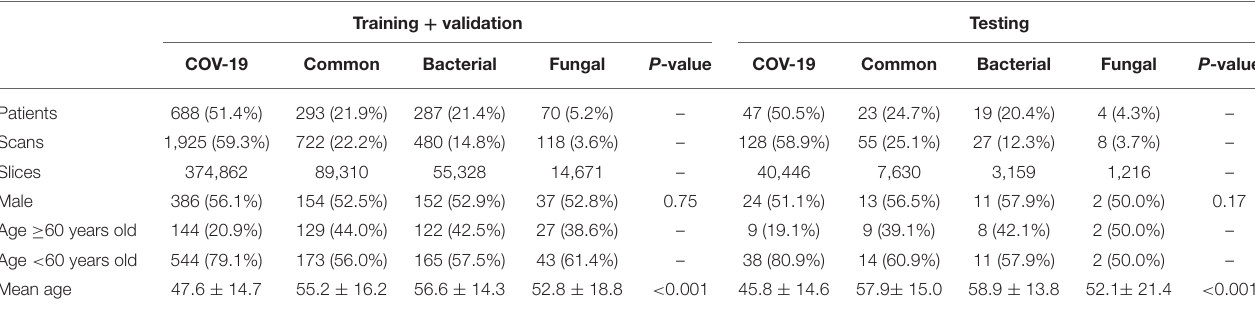
TABLE 1 | Summary of training + validation and testing datasets by four pathogenic